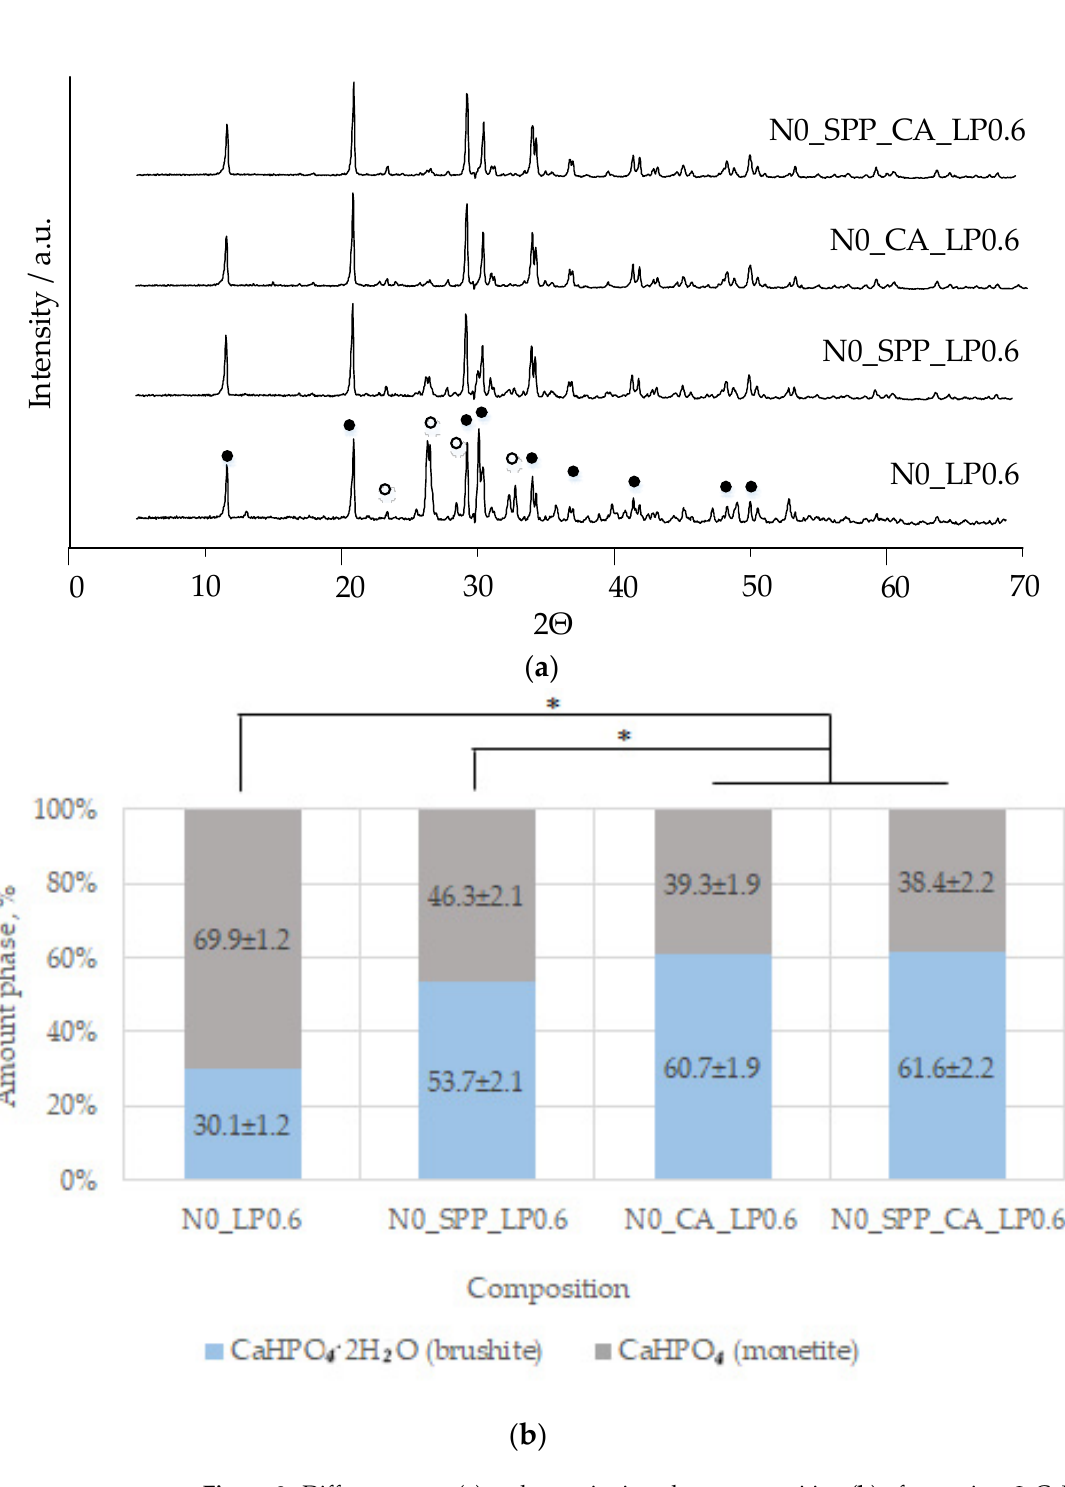
8 binding of P 2 O 74- ions to the nuclei of reaction products, embedding these ions into the crystal lattice, which stops growth and aggregation. Table 4. Setting time of cements based on Mg x Ca 3−x (PO 4 ) 2 powders for obtaining ceramics compositions N0, N20, N40, and N60. Composition → 3:00 * the optimal setting time for each composition is highlighted in color. 3.2.2. Phase Compositions and Microstructures of Ceramics X-ray phase analysis of ceramics based on Ca 3 (PO 4 ) 2 powder, performed after 7 days